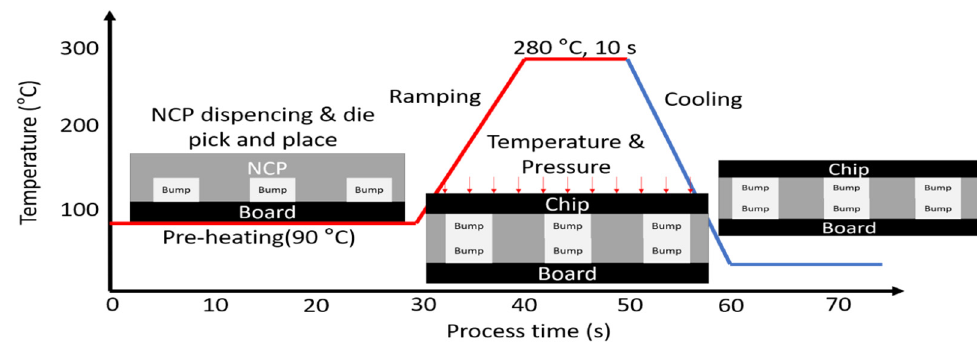
Figure 2. NCP flip-chip bonding process